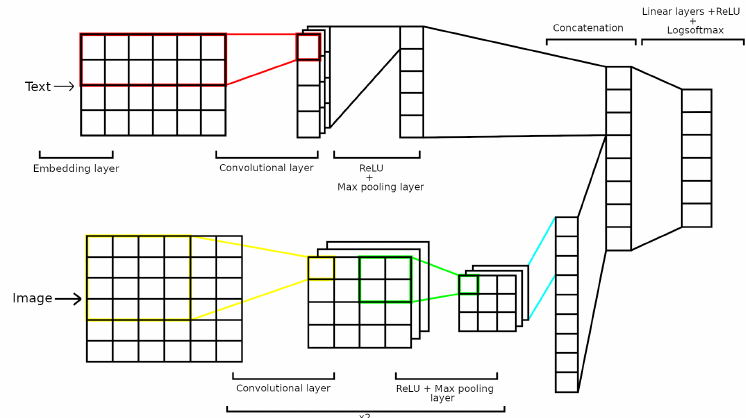
Figure 3. Architecture of the multimodal approach for fake news